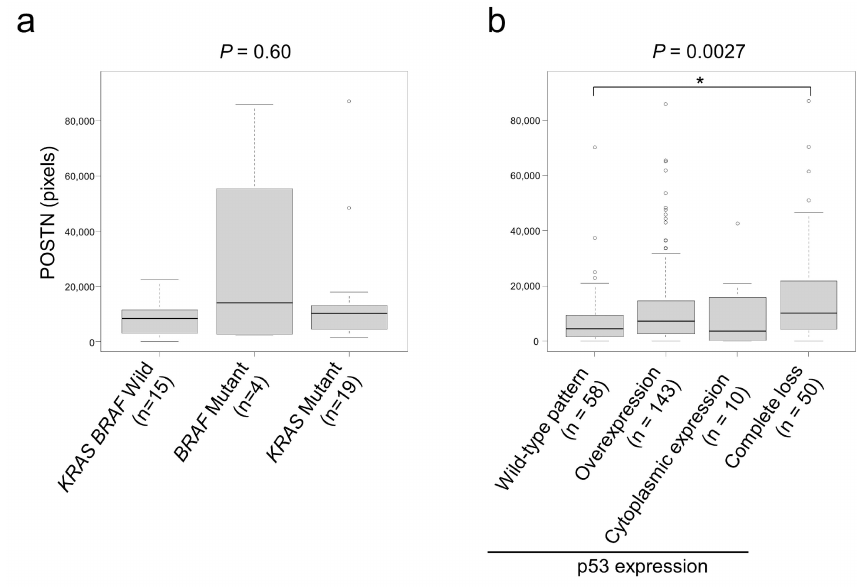
Figure 3. Association between gene mutation status and stromal POSTN expression. ( a ) Association between KRAS / BRAF mutation and stromal POSTN expression. ( b ) Associations between p53 expression patterns and POSTN expression. CRCs showing p53 complete loss expressed significantly higher levels of stromal POSTN than p53 wild-type tumors. The circles indicate outliers. *, p < 0.05.